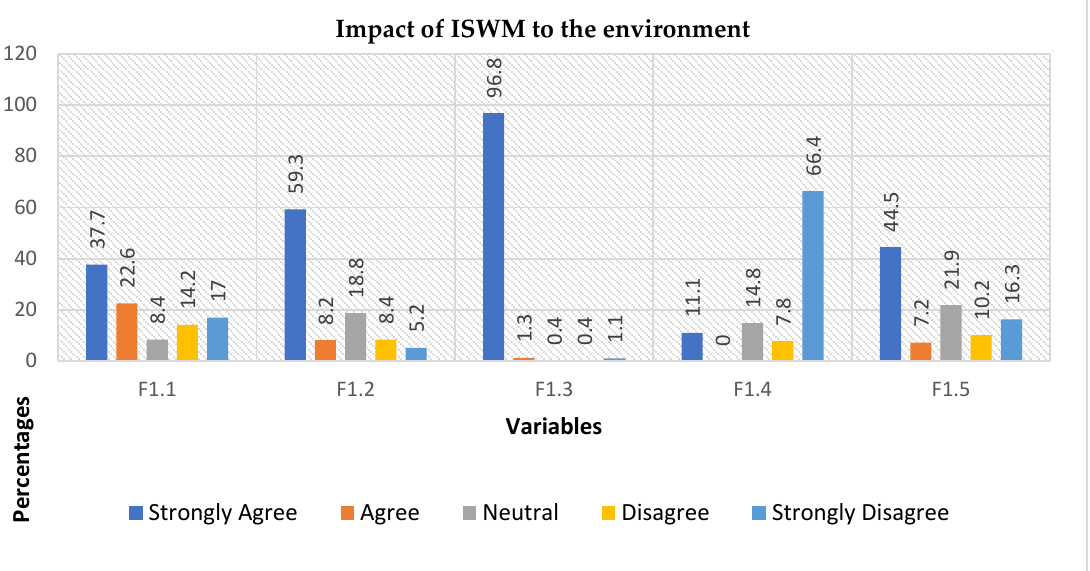
Figure 4. The illustration of various negative consequences that can be caused by poor management of indigenous solid waste. Variables are questions: F1.1 = Damage to the environment, F1.2 = Water and land pollution, F1.3 = Improving indigenous SW, F1.4 = Greenhouse generation, F1.5 = Leachate contamination.